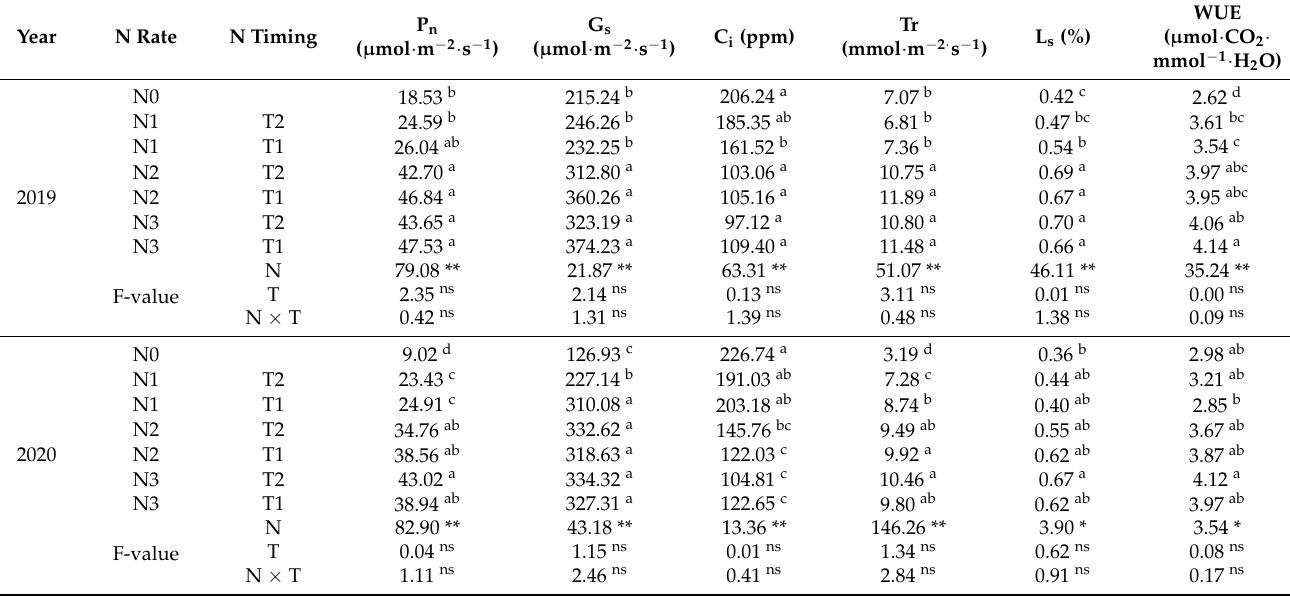
Table 1. Photosynthetic characteristics of maize as affected by nitrogen (N) supply